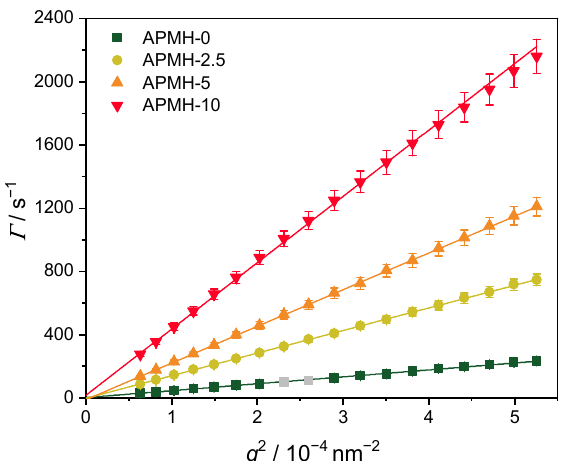
Figure 1. Relaxation rates Γ measured by angle-dependent PCS plotted against q 2 with linear regressions. Grey data points were excluded due to deviations resulting from a formfactor